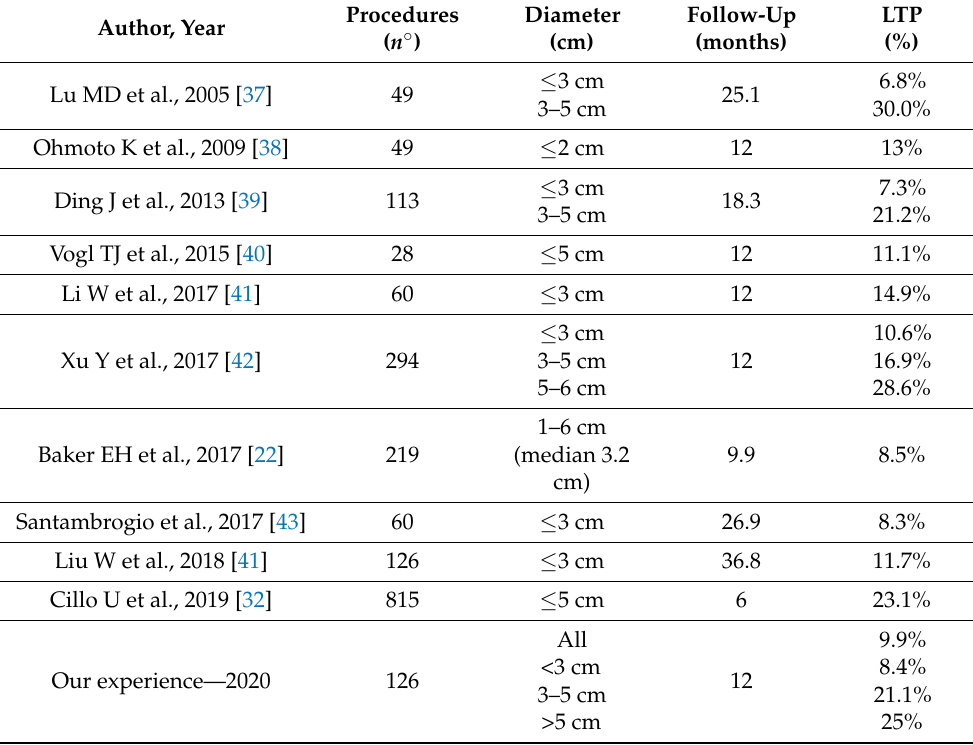
Table 5. Comparison to other experiences in the